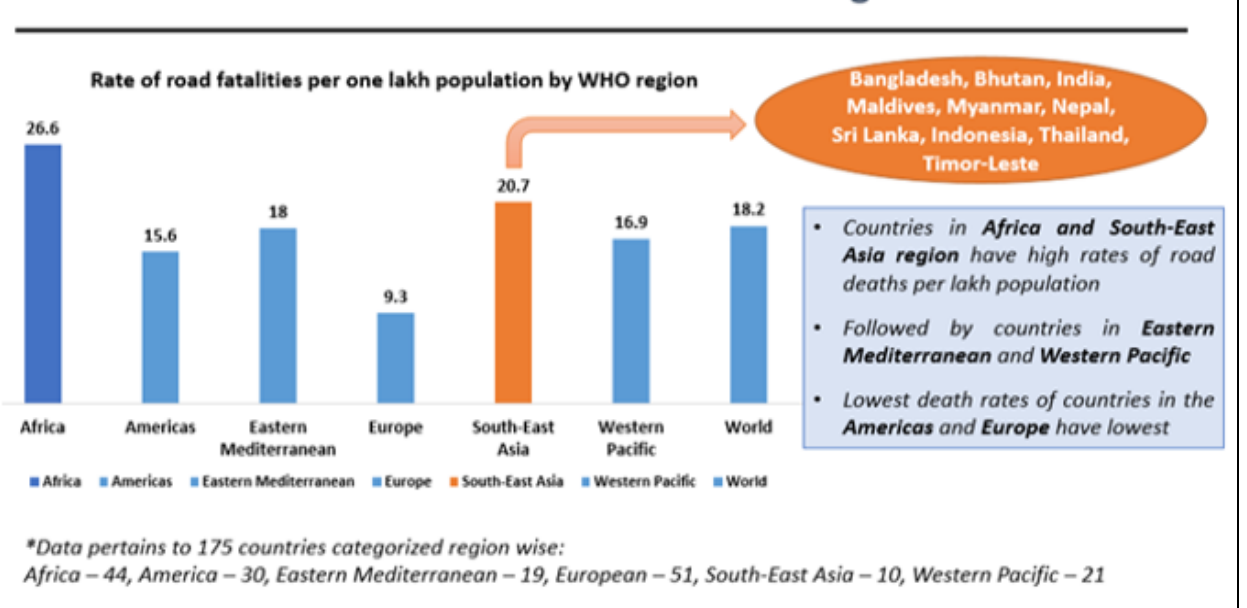
Figure 1: Rate of road fatalities per 0.1 million population by WHO region. Source: